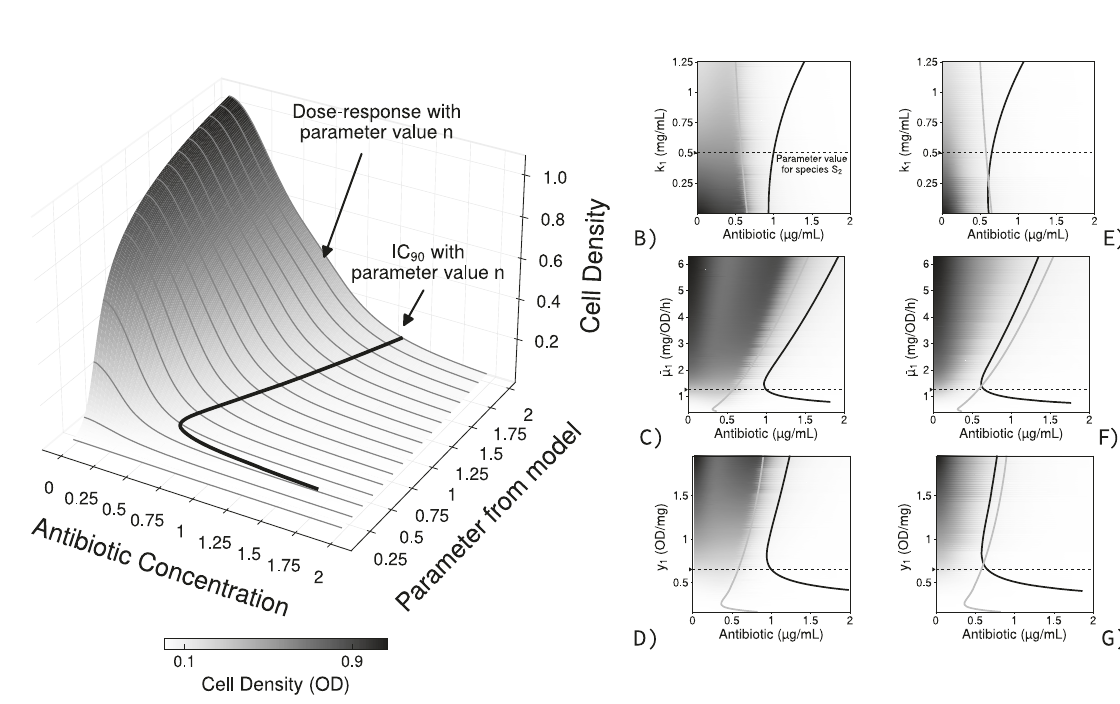
Fig. 1 S 1 drug sensitivity pro fi les in pure and mixed culture growth conditions alongside species S 2 . A Growth of species S 1 , with different parameter values (k 1 μ 1 , and y 1 ), after 24 h of growth in the presence of different antibiotic concentrations. I aggregated the resulting dose ‐ response pro fi les (blue) to create a density map from low predicted cell density (white) to high predicted cell density (black). B – D IC 90 , antibiotic concentration inhibiting 90% (IC 90 ) the growth predicted without drug, resulting with different parameters values for the half ‐ saturation parameter k 1 ( B ), maximal carbon up ‐ take μ 1 ( C ), or biomass yield y 1 ( D ) in eq. 1 when species S 2 is drug ‐ sensitive. The IC 90 for species